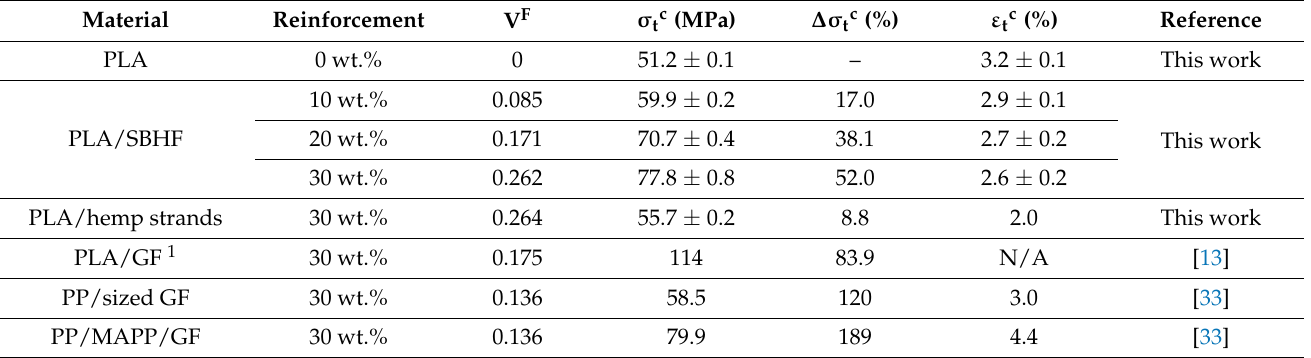
Table 2. Tensile strength and relative enhancements over the PLA matrix that were attained by PLA/SBHF, in comparison to PLA/untreated hemp, PLA/GF, and PP/GF. The elongation and the volume fraction are also